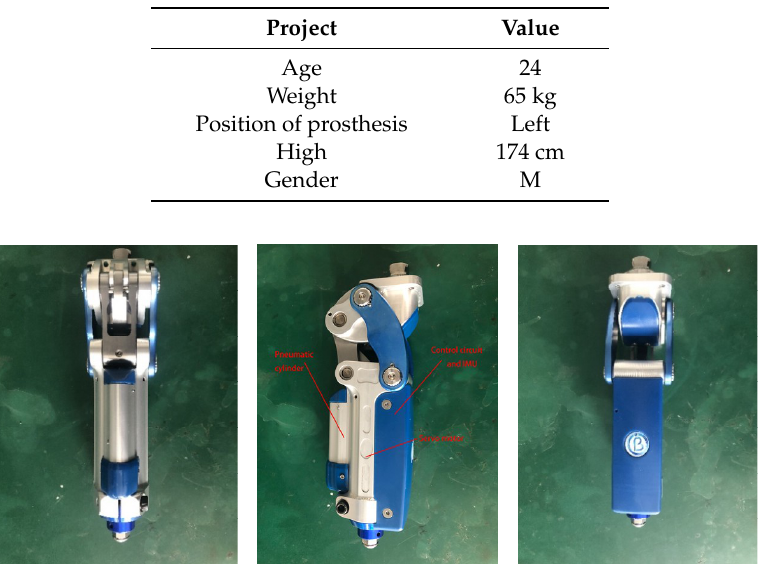
Table 7. Main specifications of devices.